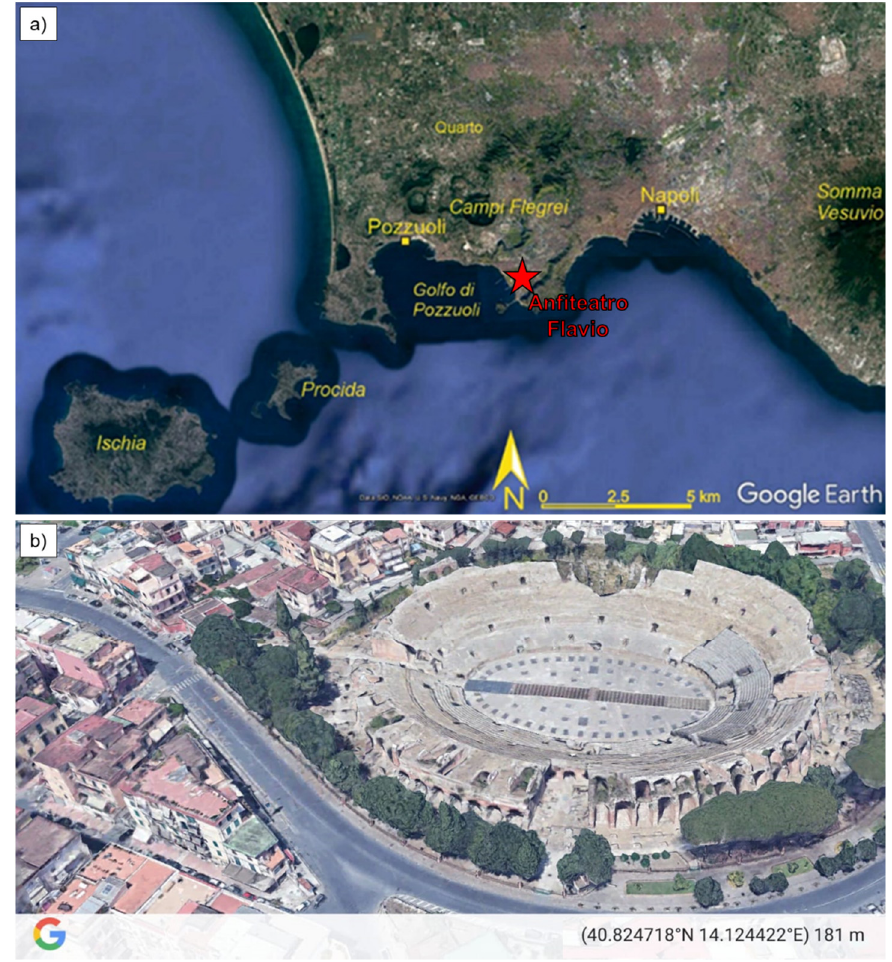
Figure 1. ( a ) Map of Phlegraean Fields area with location of Anfiteatro Flavio (red star) in the Pozzuoli Town; ( b ) 3D image of Anfiteatro Flavio.